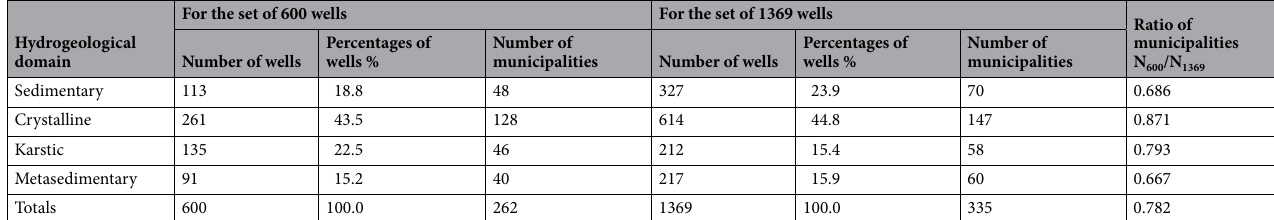
Table 2. Number of wells and municipalities per hydrogeological domain, and related percentages, for the set of 600 and 1369 wells. For the total of 1969 wells, the number of wells per hydrogeological domain is: Sedimentary (440 or 22.4%), Crystalline (875 or 44.4%), Karstic (346 or 17.6%), and Metasedimentary (308 or